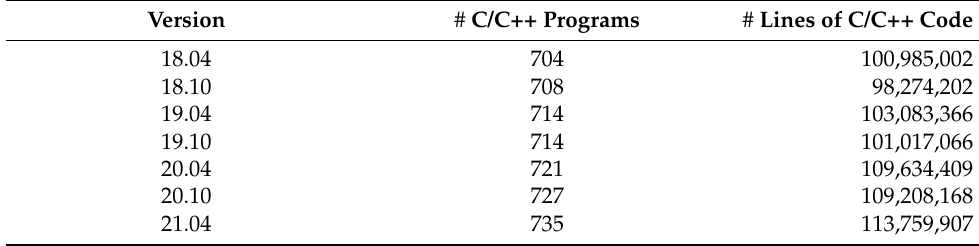
Table 1. Basic information about the n = 8 Ubuntu